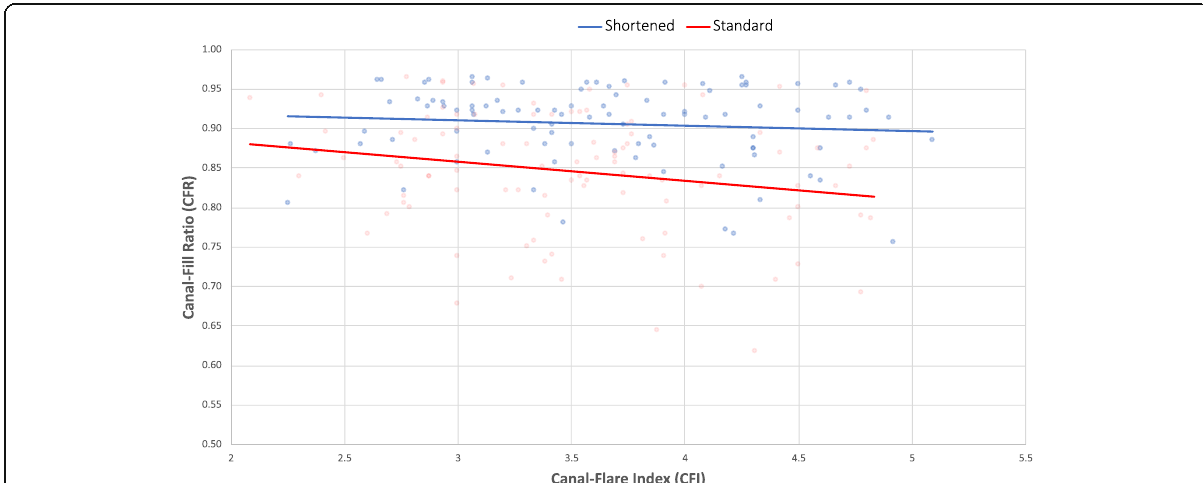
Fig. 4 Scatterplot of the canal-fill ratio (CFR) of the shortened and standard stems at the level of the tip of the lesser trochanter, in relation to the patients ’ canal-flare index